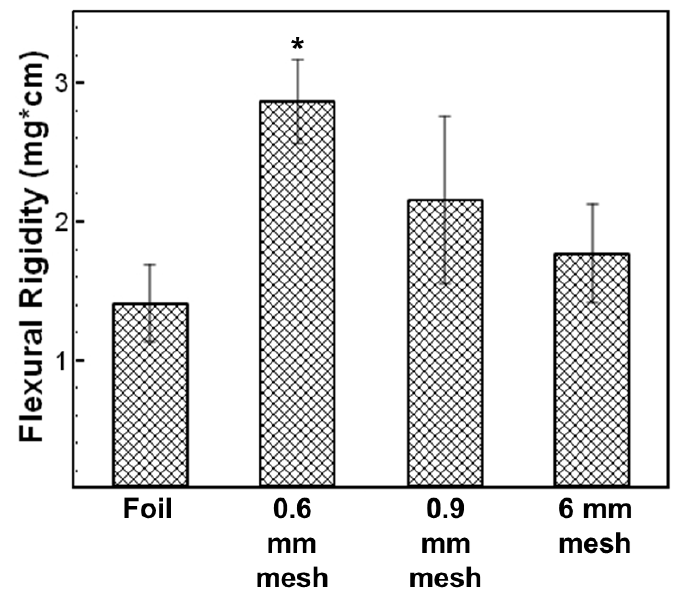
Figure 3. Flexural rigidity (a measure of stiffness) of the electrospun samples measured using the heart loop method. * indicates statistically different from sample spun on foil (no patterning) ( t test, α =